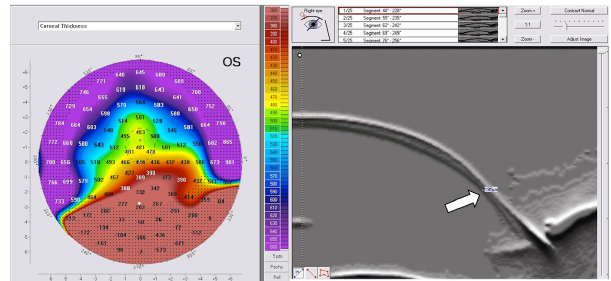
Figure 2. Inferior corneal thinning on corneal pachymetry in PMD. A: Bell sign on the thickness map, it is an indicator of inferior corneal thinning; compare values between the inferior part of this cornea with other peripheral parts. B: Scheimpflug image showing the thinning (white